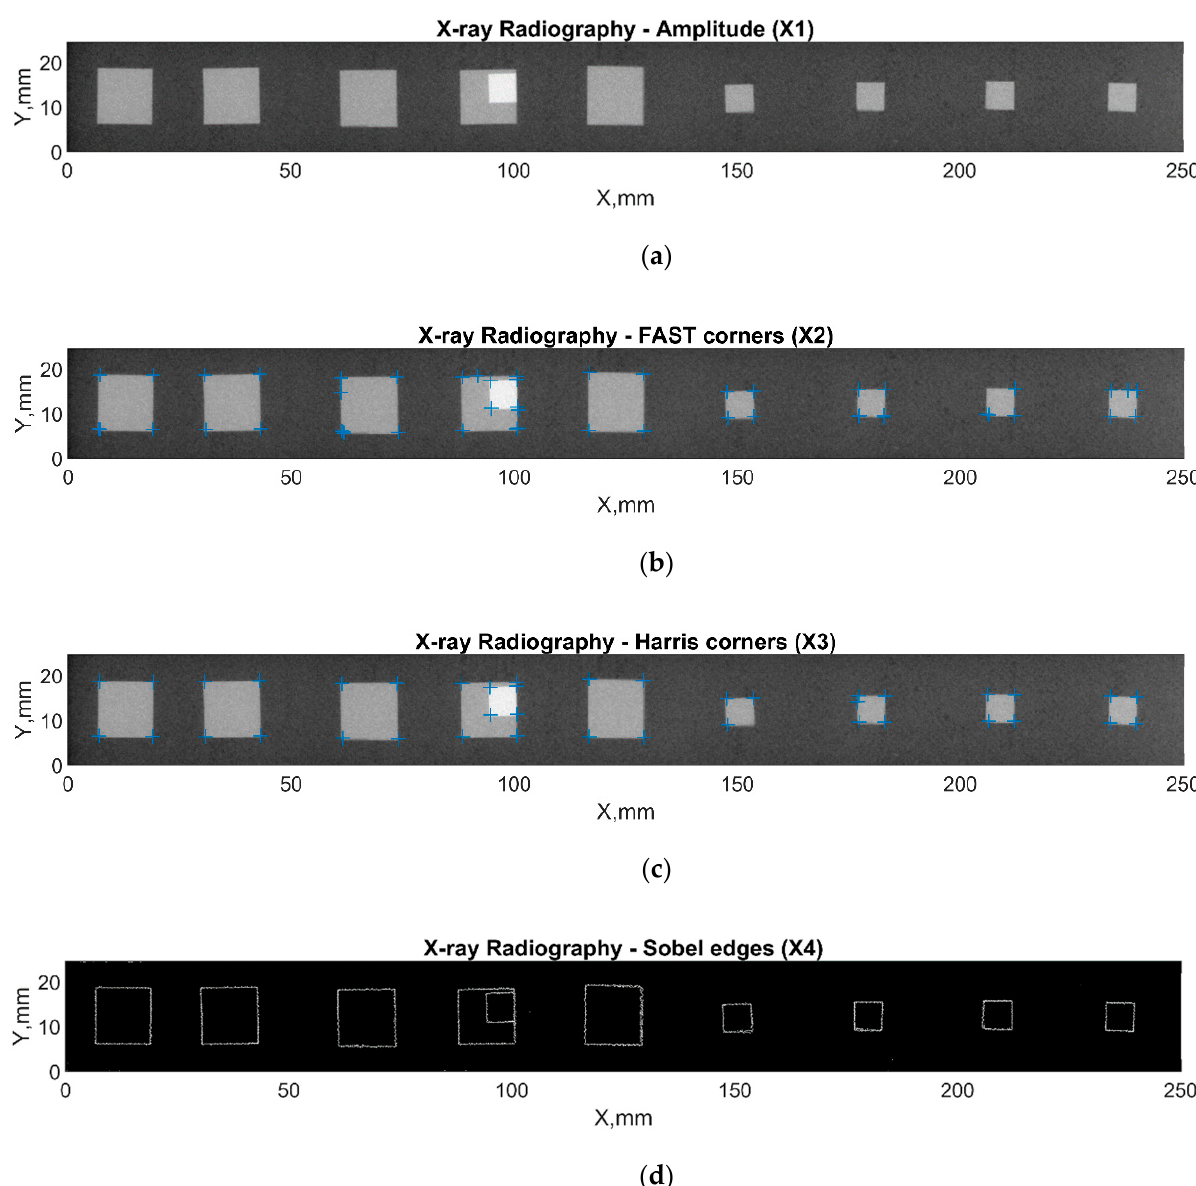
Figure 12. Features extracted from radiography images: ( a ) radiography; ( b ) FAST corners; ( c ) Harris corners; ( d ) Sobel edges.